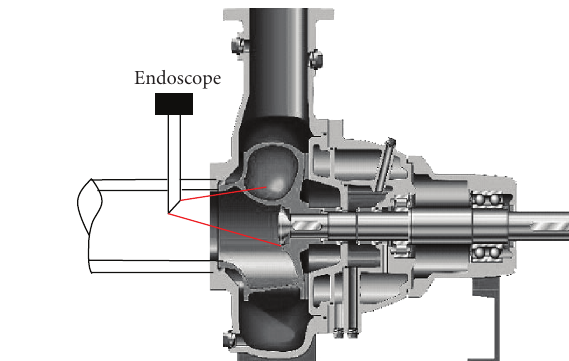
Figure 11: Position of endoscope.